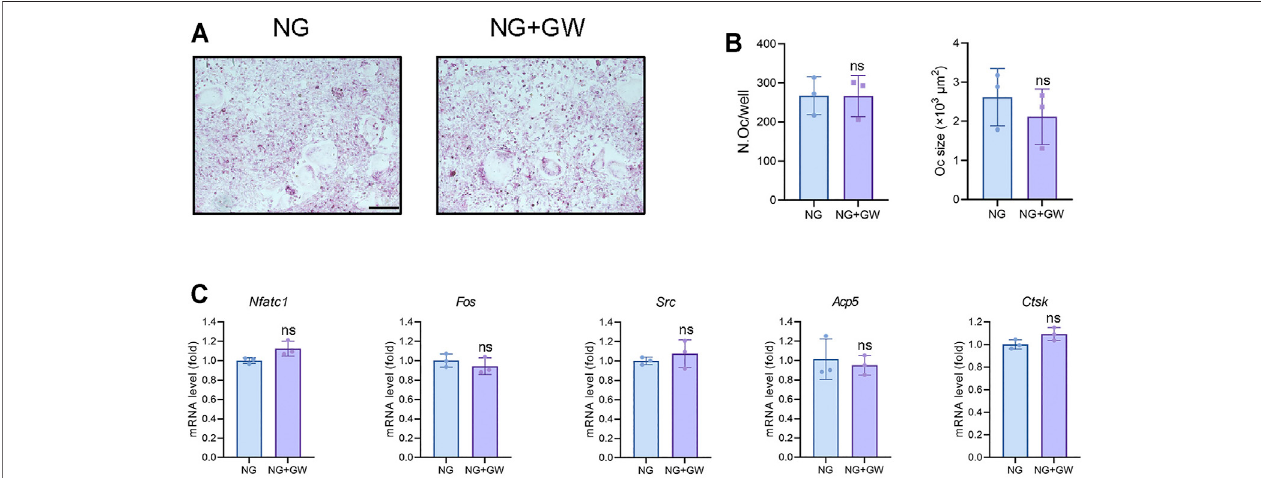
FIGURE 3 | PPAR β / δ agonist cannot directly regulate osteoclast differentiation in vitro . (A) TRAP staining for osteoclast differentiation before and after PPAR β / δ agonist treatment. Scale bar (cid:2) 100 μ m. (B) Statistics on the number and size of osteoclasts. (C) RT-PCR results of the expressions of the osteoclastogenesis-related genes before and after PPAR β / δ agonist treatment. Data were expressed as mean ± SD. The p values were calculatedby two-tailed Student ’ s t test. (ns, not statistically signi fi cant). N. Oc (cid:2) number of osteoclasts.